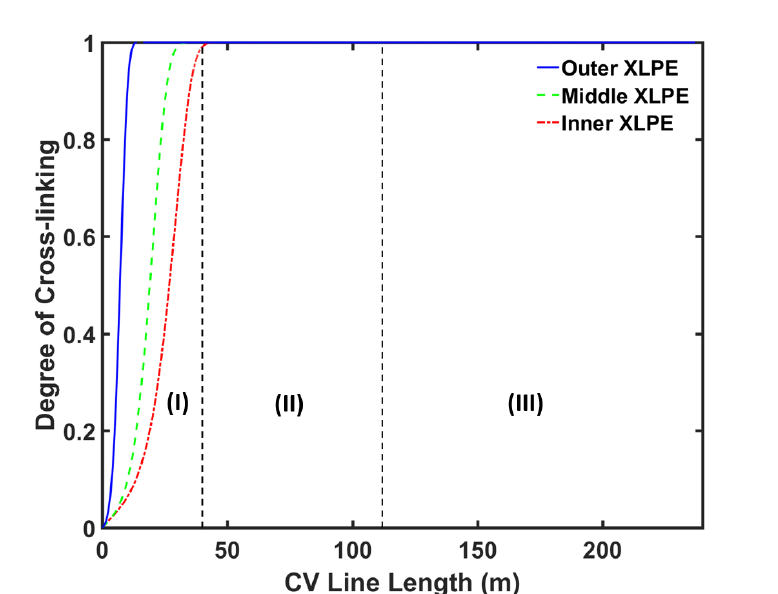
Figure 7. CV line cross-linking profile at different distances from the cable centre. Segments (I), (II) and (III) correspond to the curing tube and transition zone, water-cooling, and air-cooling segments, respectively.